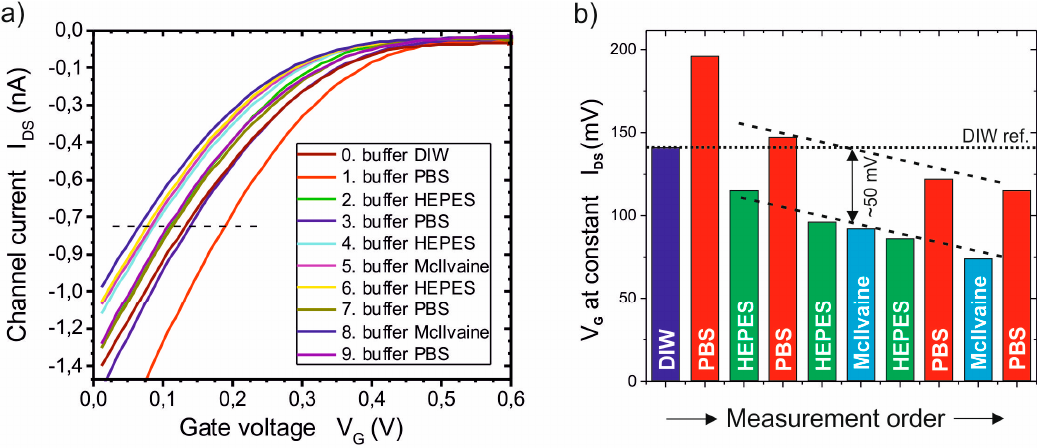
Figure 1. ( a ) Transfer characteristics of SGFET measured with tree buffers; ( b ) Gate voltage shifts as a function of various buffer solutions measured constant I DS current at 0.75